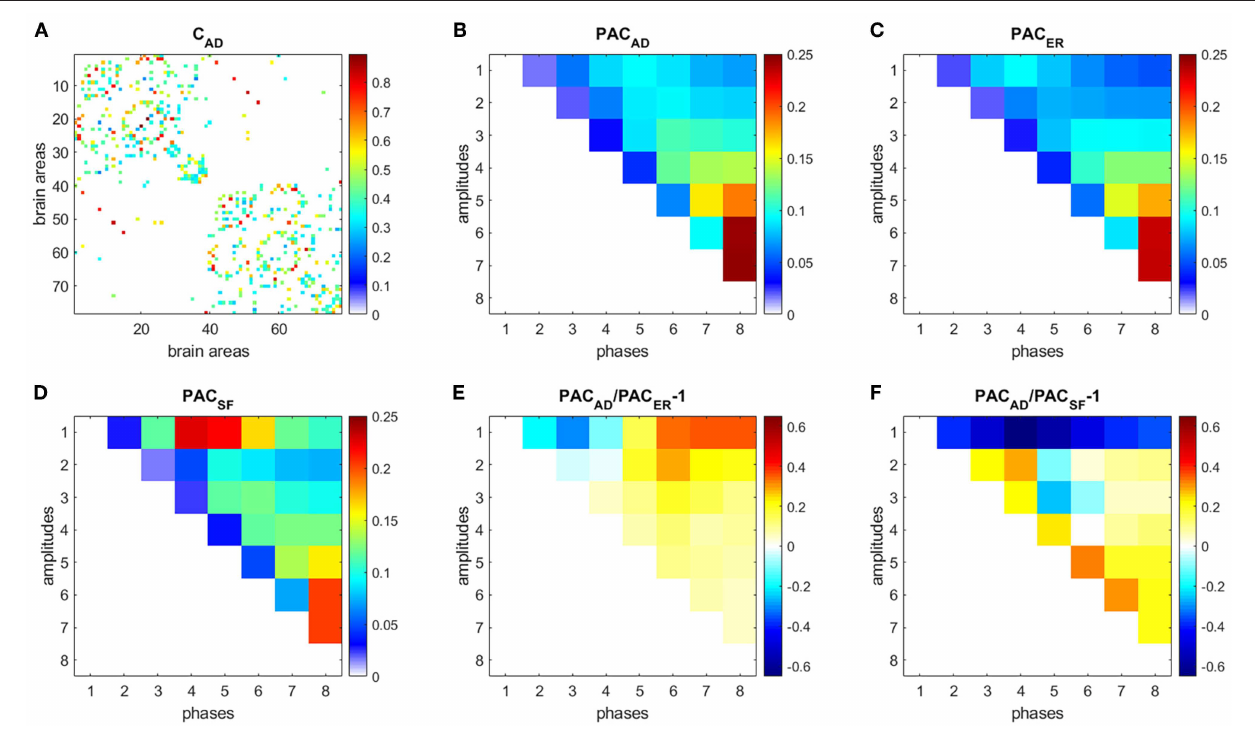
FIGURE 6 | PAC in AD. (A) Connectivity matrix. (B) PAC averaged over 31 AD subjects. (C) Average PAC generated from 500 equivalent ER networks. (D) Average PAC generated from 500 equivalent SF networks. (E) Comparison of PAC from AD and PAC generated from equivalent ER networks. (F) Comparison of PAC from AD and PAC generated from equivalent SF networks.